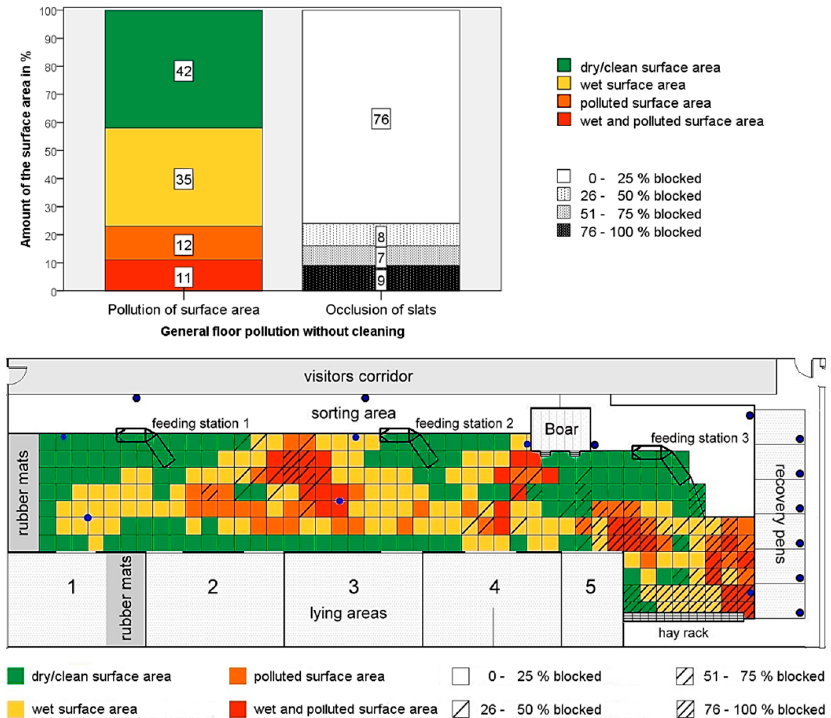
Figure 3. ‘Representative floor pollution’; Above: Average pollution without cleaning over three randomly selected days before the start of the experiment. Below: Housing plan with distribution of floor pollution from 24.02.2014.